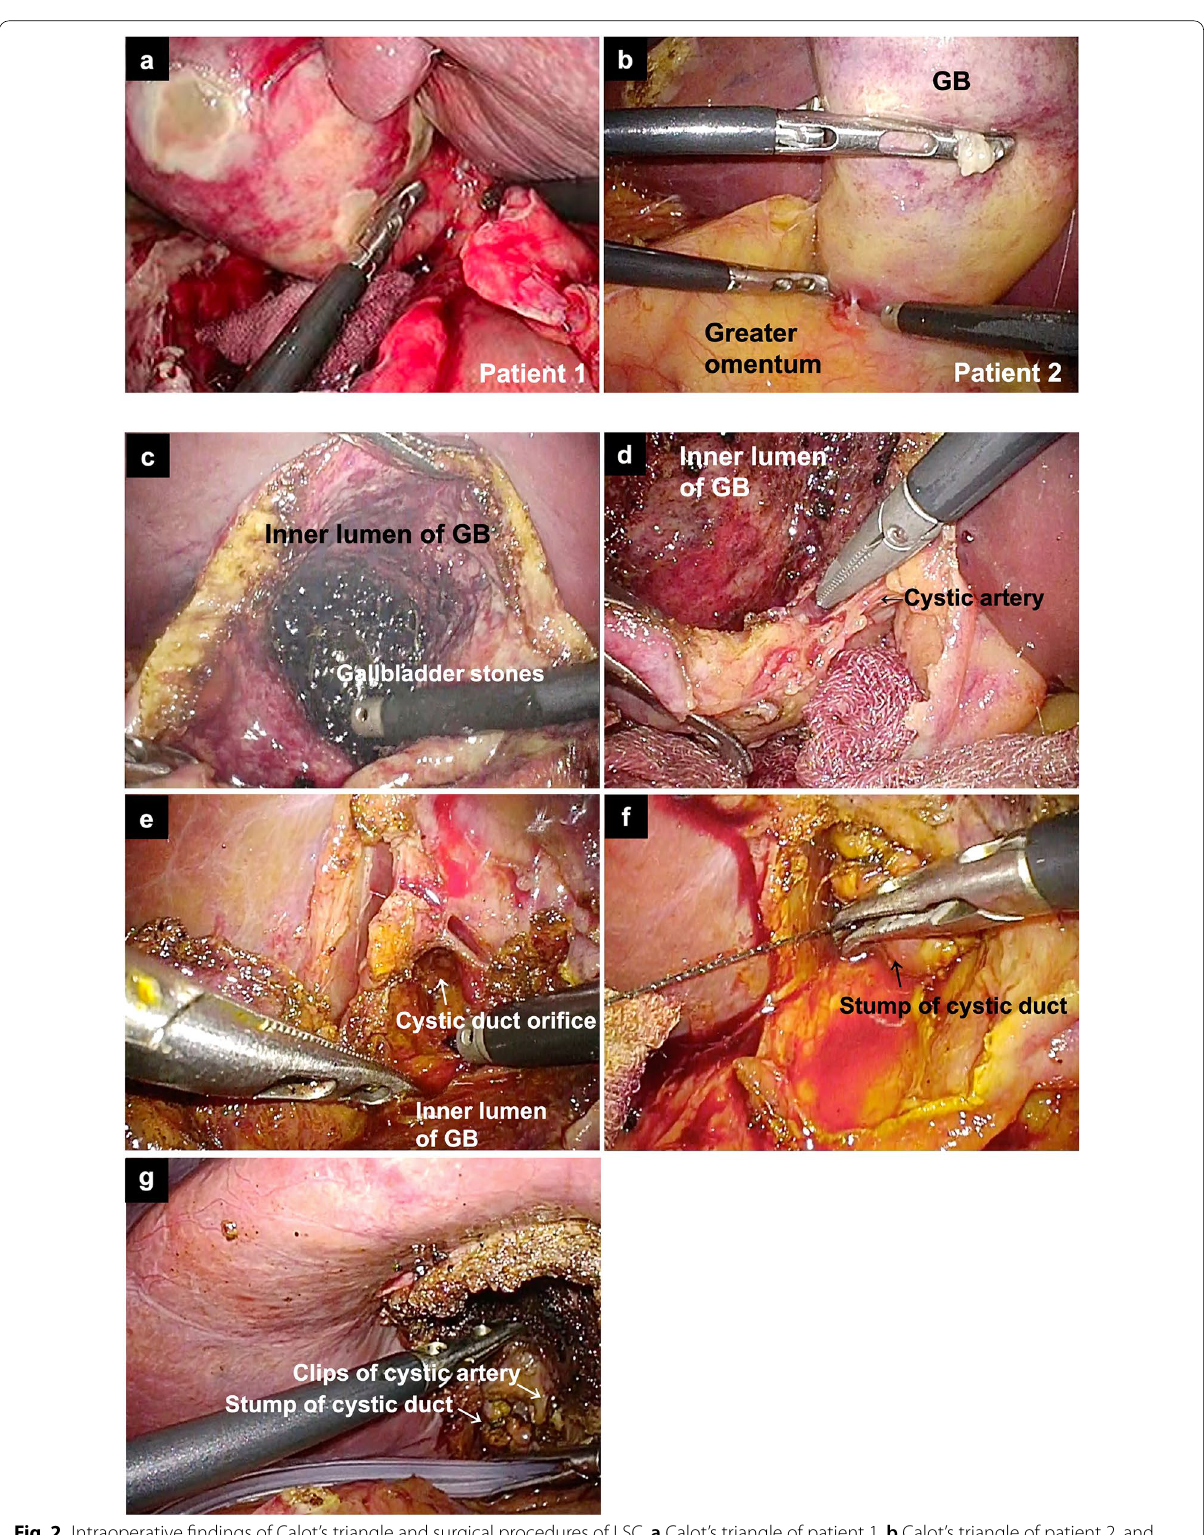
Fig. 2 Intraoperative findings of Calot’s triangle and surgical procedures of LSC. a Calot’s triangle of patient 1. b Calot’s triangle of patient 2, and dissection of adhesion around GB and liver. c Making incision on the GB wall and aspiration of the contents in GB. d Identification of cystic artery and clipping. e Identification of cystic duct orifice from the inner lumen of GB after removal of GBS. f Suture using an absorbable 3–0 V-Loc. g Placement of drainage tube beside the